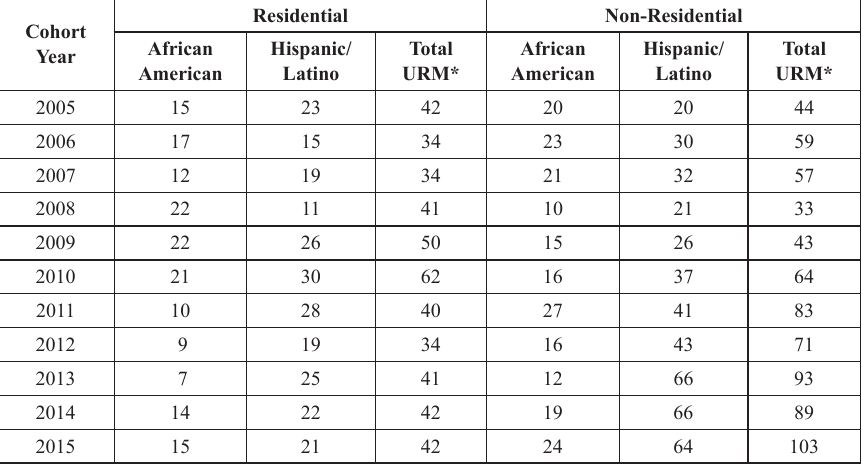
Table 3. Eleven years of enrollment of first time, full-time students into the College